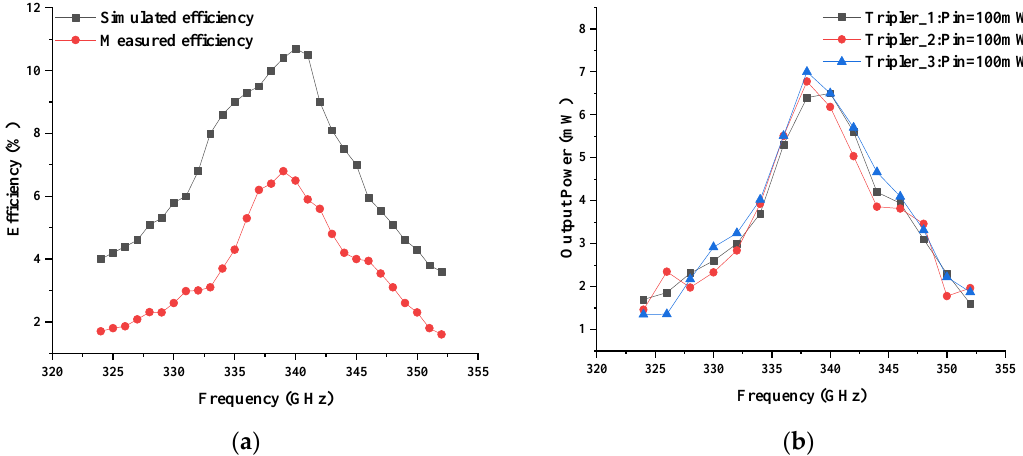
Figure 12. Measured ( a ) output power and ( b ) frequency conversion efficiency of the 0.34 THz tripler with different input power levels from 324 GHz to 352 GHz.